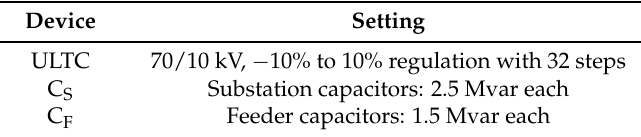
Table 2. Configuration of reactive power devices.